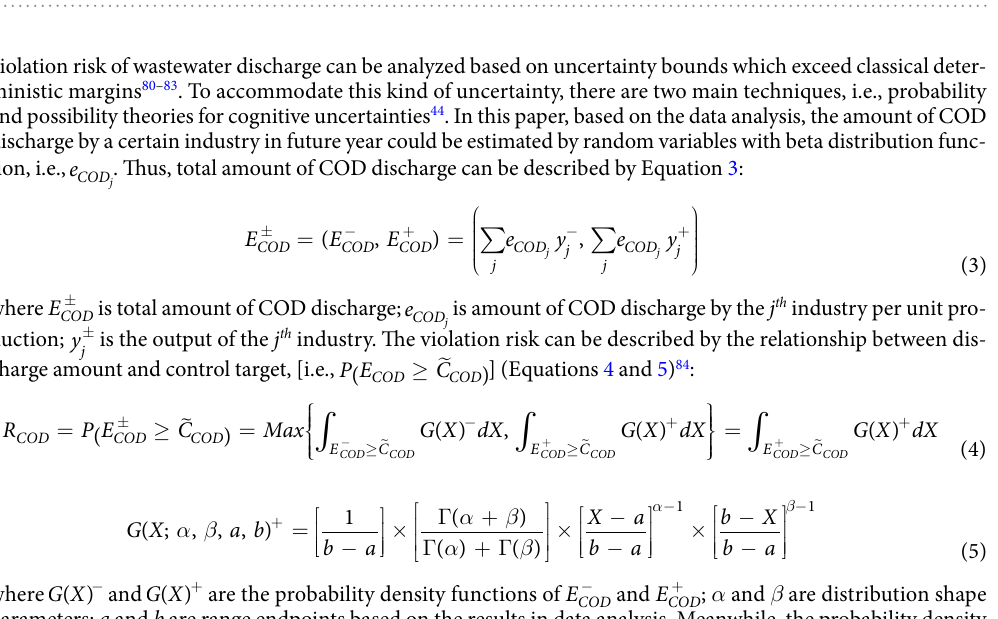
Table 1. Transformation